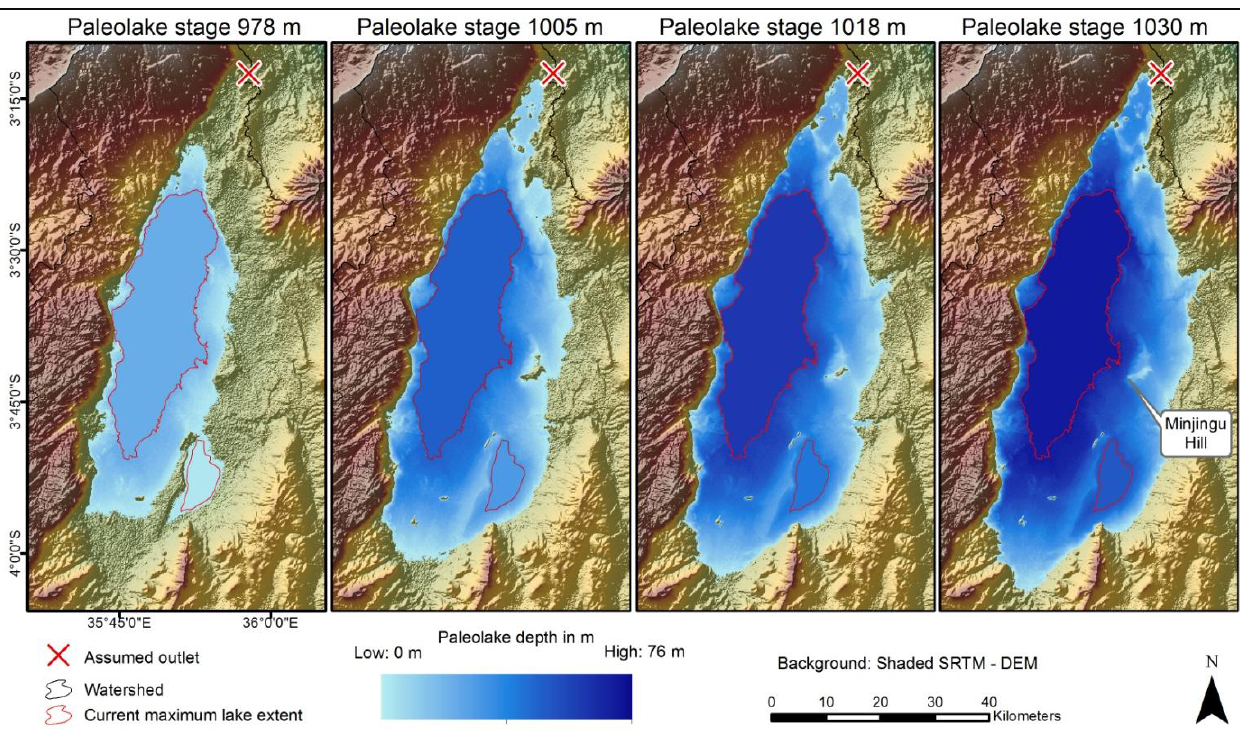
Figure 6. Different paleolake